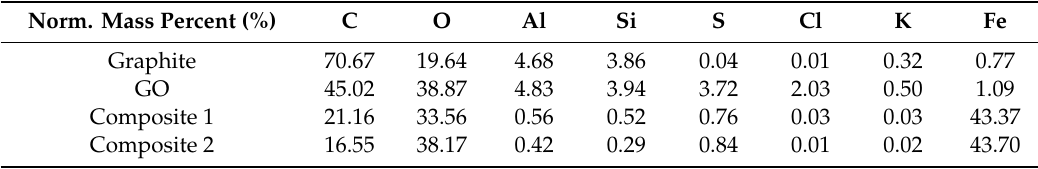
Table 1. Normalized mass percent average value of graphite, GO, and composites measured by EDX. Norm. Mass Percent (%)